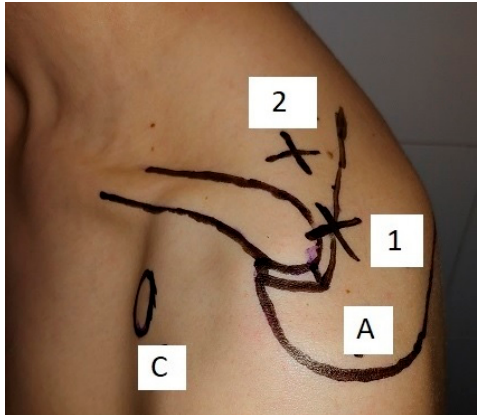
Figure 5. Schematic top view of the right shoulder with the refferal point for establishing Neviaser (blue cross) and LaFosse (green cross) portals. C: coracoid, SN: suprascapular nerve, SA: suprascapular artery, SNo: suprascapular notch, SGNo: spino-glenoid notch.